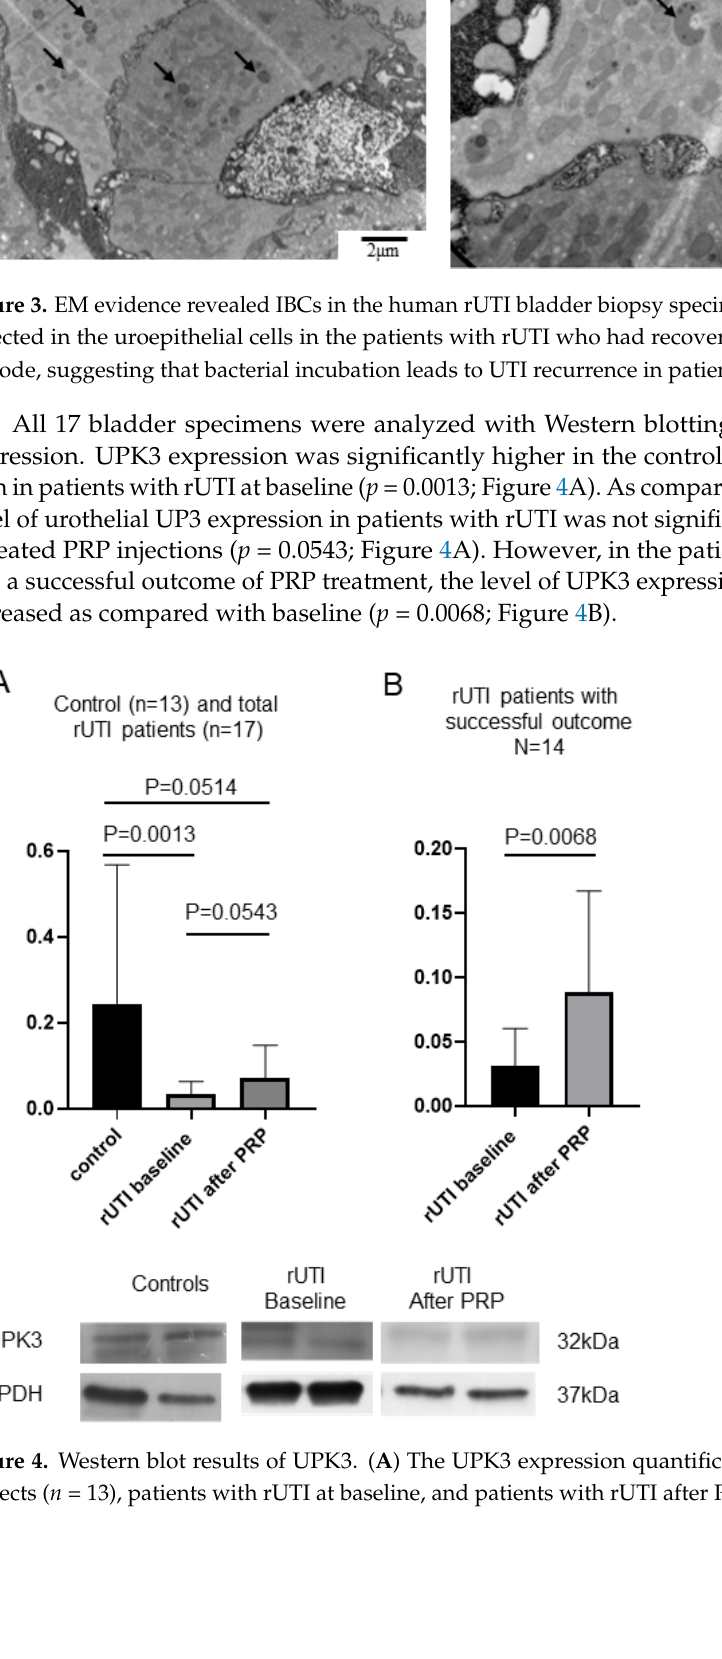
Figure 2. Proportion of bladder ultrastructural defects in patients with rUTI. ( A ) The bladders from patients with rUTI exhibited various ultrastructural defects on EM. ( B ) The proportion of changes in bladder ultrastructural defects in patients with rUTI after intravesical PRP injections.